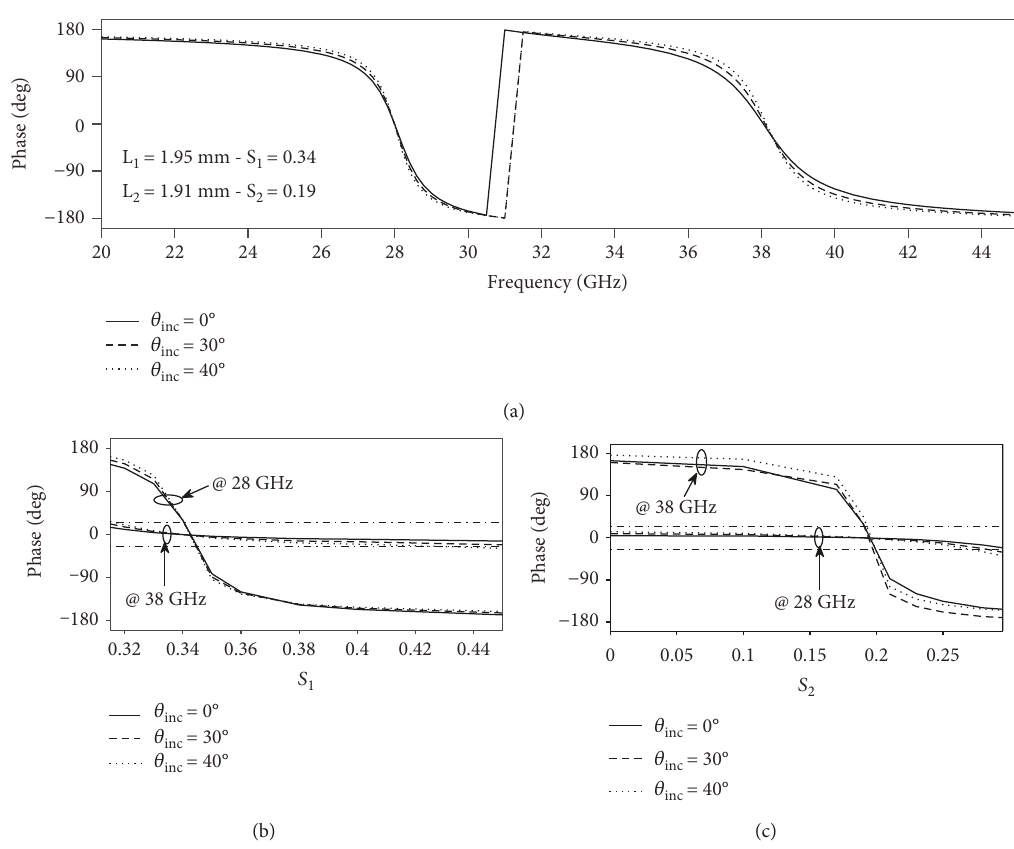
Figure 7: Simulated re fl ection phase curves for di ff erent incidence angles: (a) phase vs. frequency; (b) phase vs. the scaling factor S operating frequencies ( L 1 = 1 95 mm , S 1 = variable and L 2 = 1 91mm , S 2 = 0 19 ); (c) phase vs. the scaling factor S 2 at the two operating frequencies ( L 1 = 1 95mm , S 1 = 0 34 and L 2 = 1 91mm , S 2 = variable